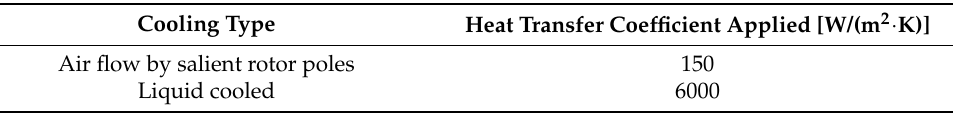
Table 9. Heat Transfer Coefficients Guideline.